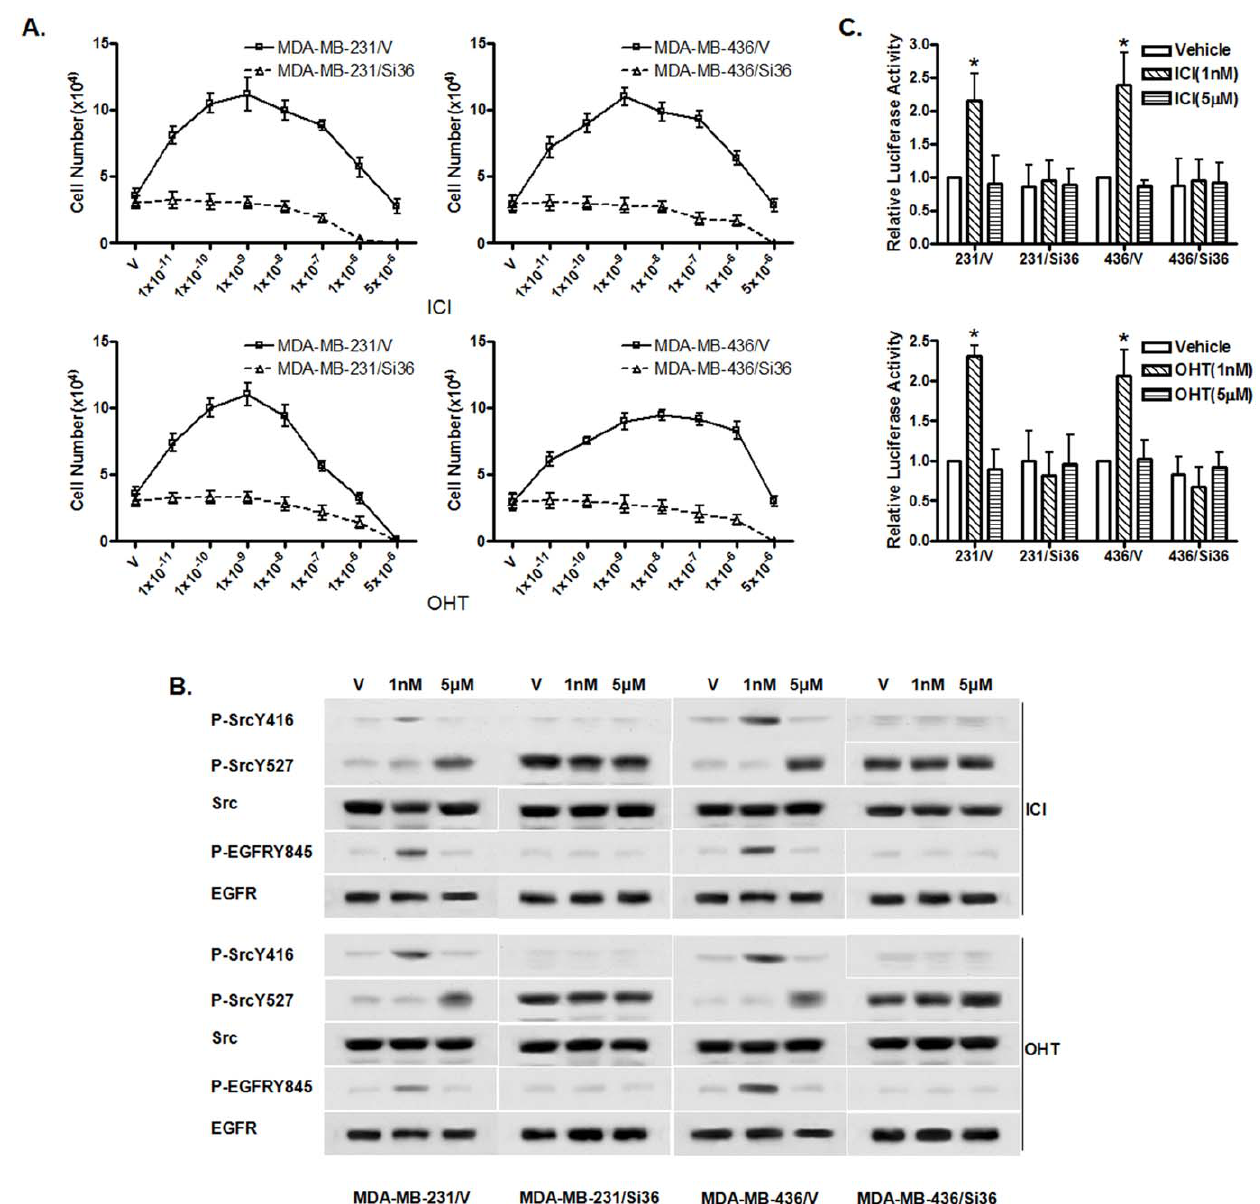
Figure 6. ER- a 36 mediates biphasic antiestrogen signaling in ER-negative breast cancer cells. (A). The effects of antiestrogens on the proliferation rate of MDA-MB-231 and MDA-MB-436 cells with or without ER- a 36 expression knocked-down. Cells maintained for three days in phenol red-free DMEM plus 2.5% dextran-charcoal-stripped fetal calf serum were treated with indicated concentrations of antiestrogens or ethanol vehicle as a control. The cell numbers were determined using an automatic cell counter after 12 days. Five dishes were used for each concentration and experiments were repeated three times. The mean cell number 6 SE are shown. (B). Western blot analysis of the effects of 1 nM or 5 m M of antiestrogens on the phosphorylation levels of the SrcY416, SrcY527 and EGFRY845 in MDA-MB-231 and MDA-MB-436 cells. (C). Cells were transfected with the luciferase reporter plasmid driven by the wild-type Cyclin D1 promoter and transfected cells were treated with vehicle (ethanol), 1 nM or 5 m M of antiestrogens. Columns: means of the relative luciferase activity in transfected cells treated with vehicle that is arbitrarily set as 1.0 from three independent experiments; bars, SE. *, p , 0.05, for cells treated with vehicle (V) vs 1 nM of antiestrogens.